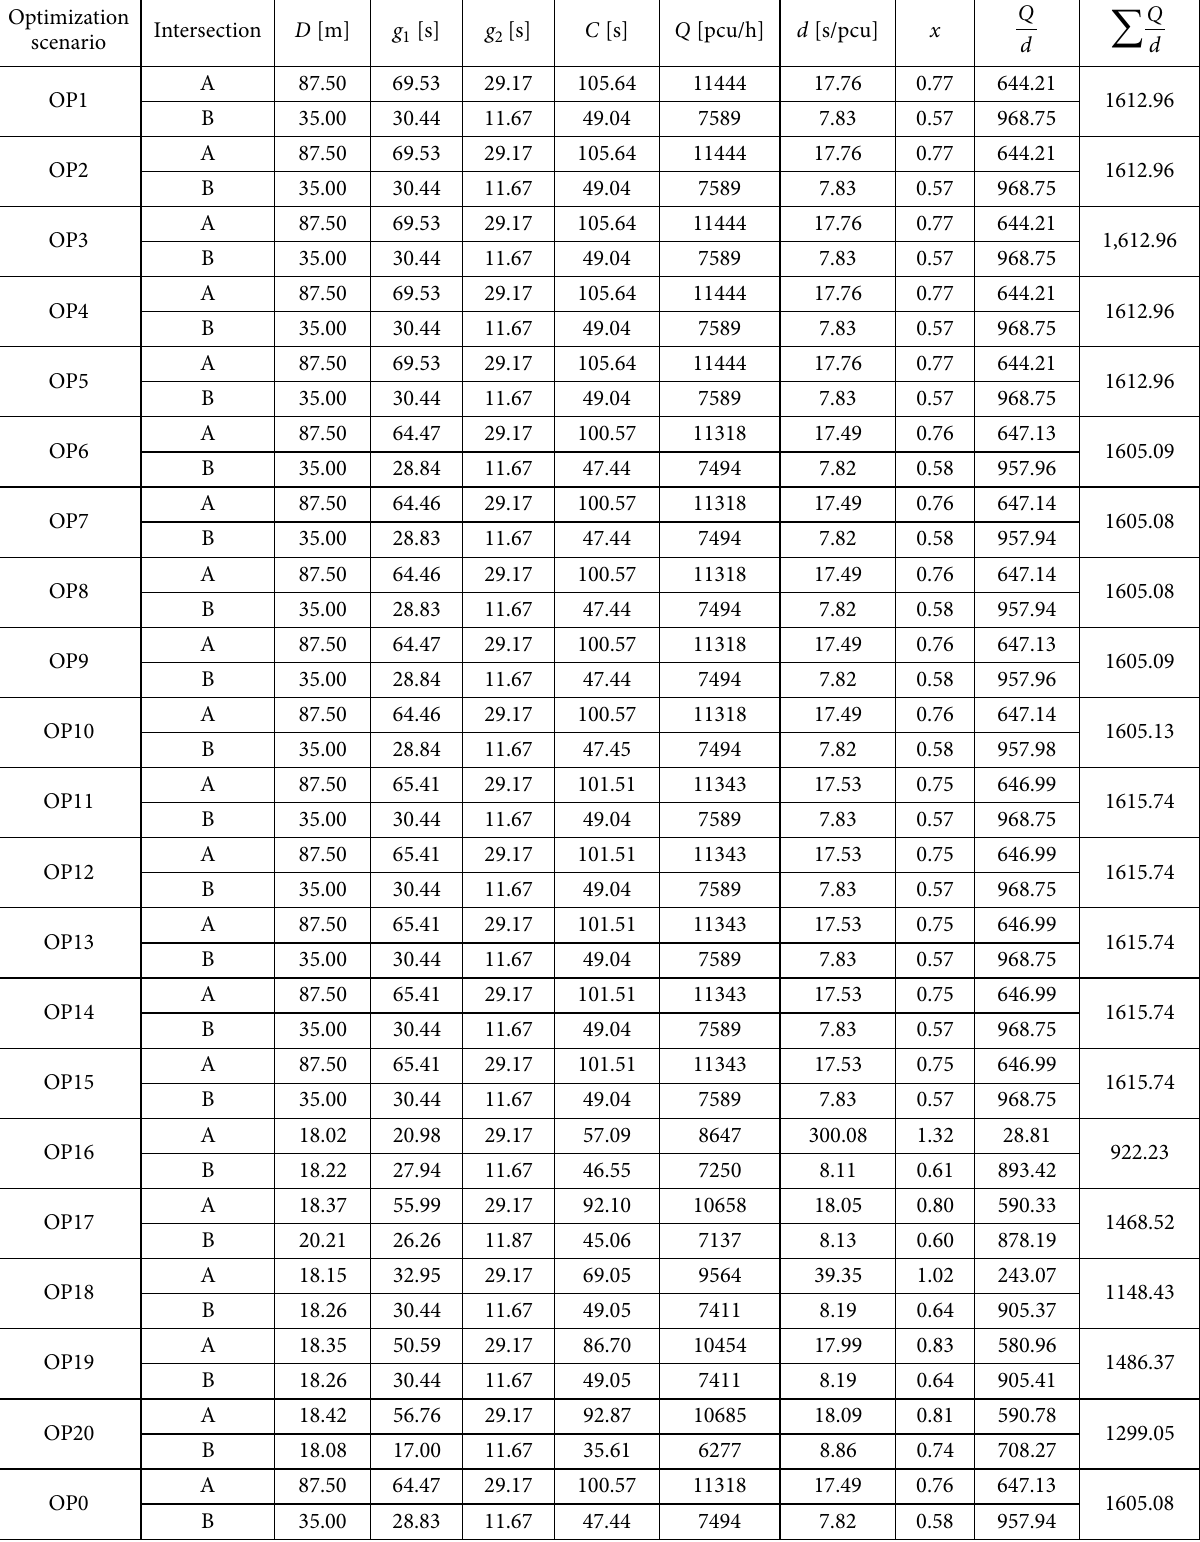
Table 4. Optimization results under different